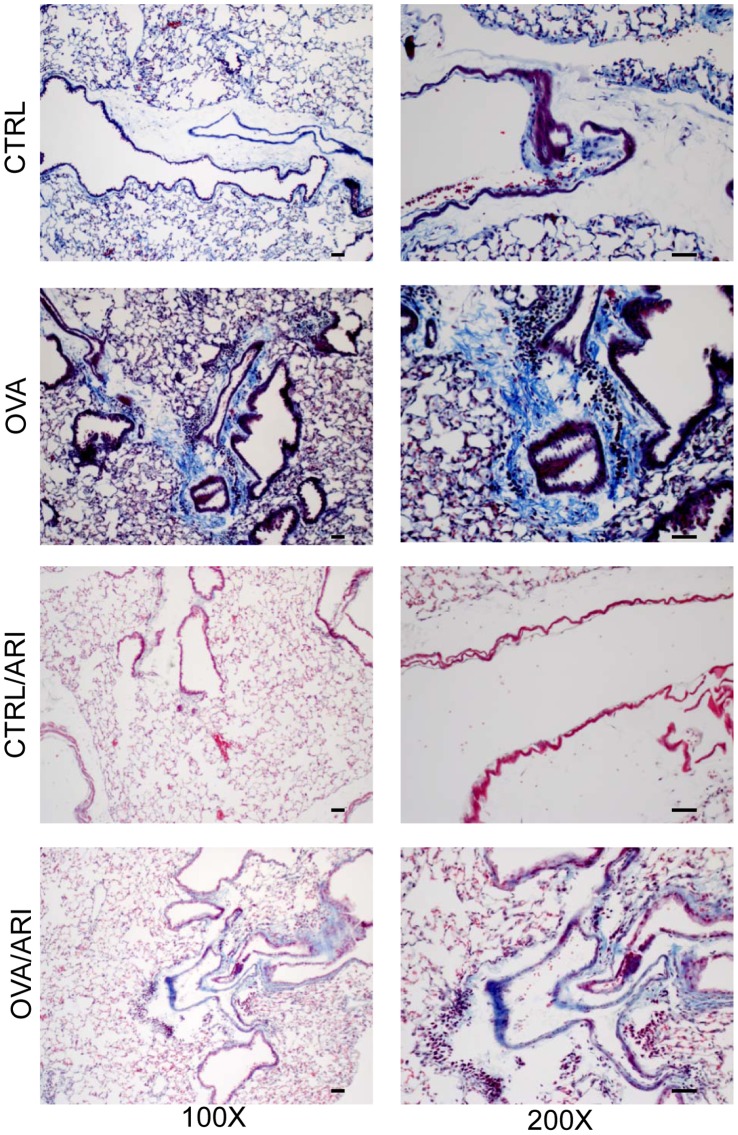
AR inhibition decreases airway remodeling in chronic asthmatic mice lungs -.The lung sections of mice after 6-weeks of OVA-challenge were stained with Masson’s trichrome staining and observed under light microscope and photomicrographs were acquired. A representative photomicrograph is shown (n = 6). Magnifications 100× and 200×. CTRL, control, ARI, aldose reductase inhibitor, OVA, ovalbumin.